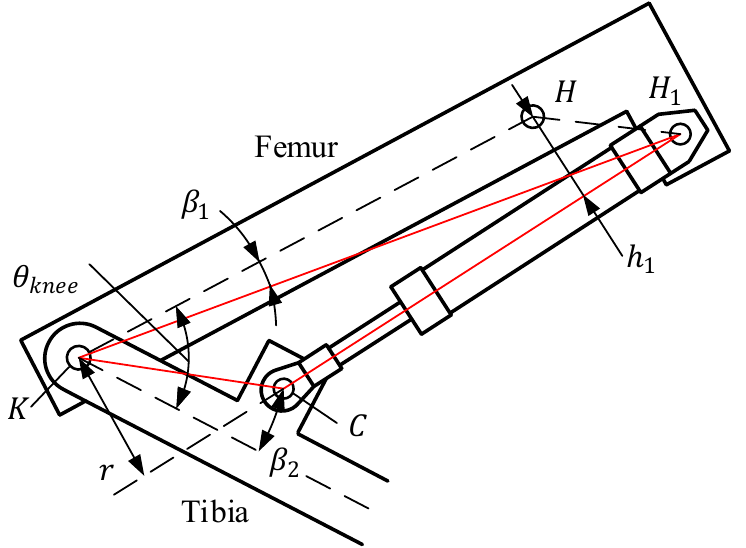
Figure 2. The DAG of the cylinder at the knee joint.